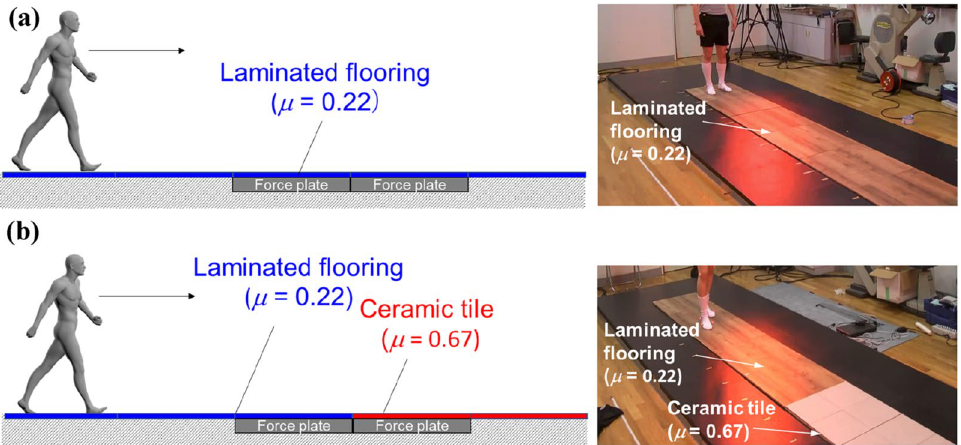
Figure 1. Floor combinations. ( a ) Low-friction and ( b ) high-friction conditions were used in this experiment. Low-friction conditions used only laminated wood flooring, whereas high-friction conditions included a transition from laminated wood flooring to the ceramic tile in the forward walking direction. The flooring and tiles for high-friction conditions were placed alongside the boundaries between the two force plates; the laminated wood flooring on the first force plate, and the ceramic tile on the second, arranged in the forward walking